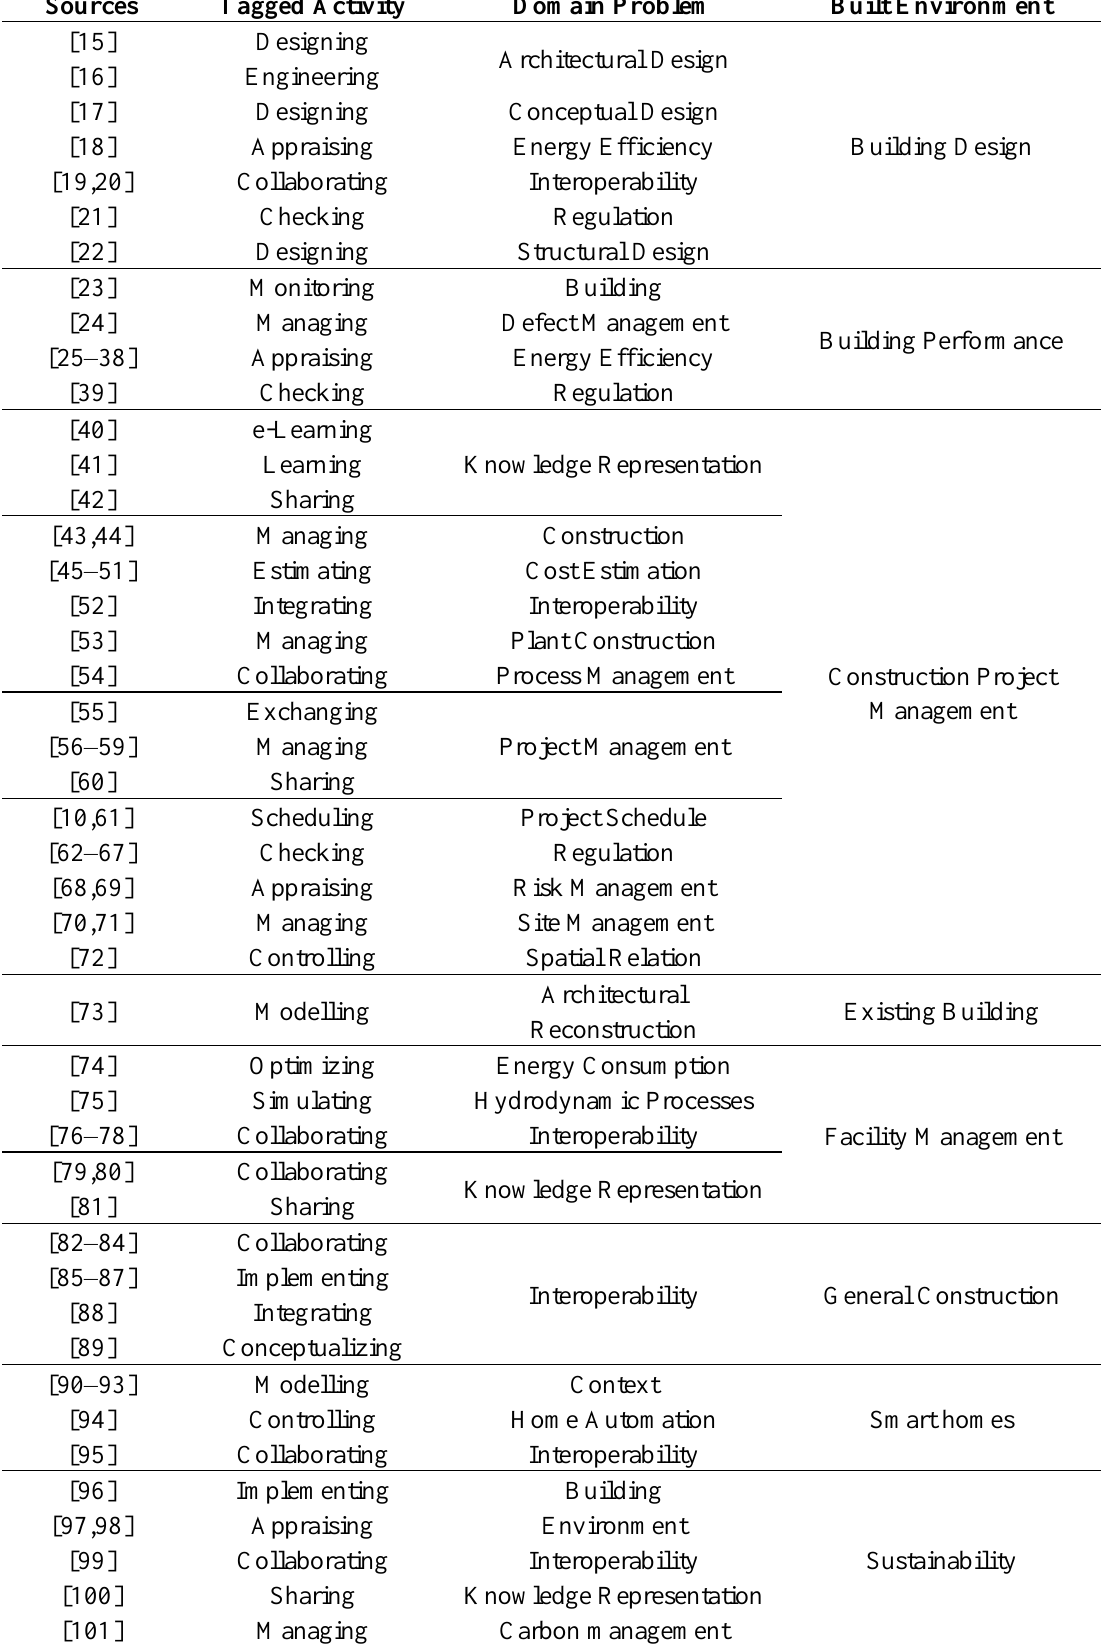
Table 1. Sematic models of professional domains in the